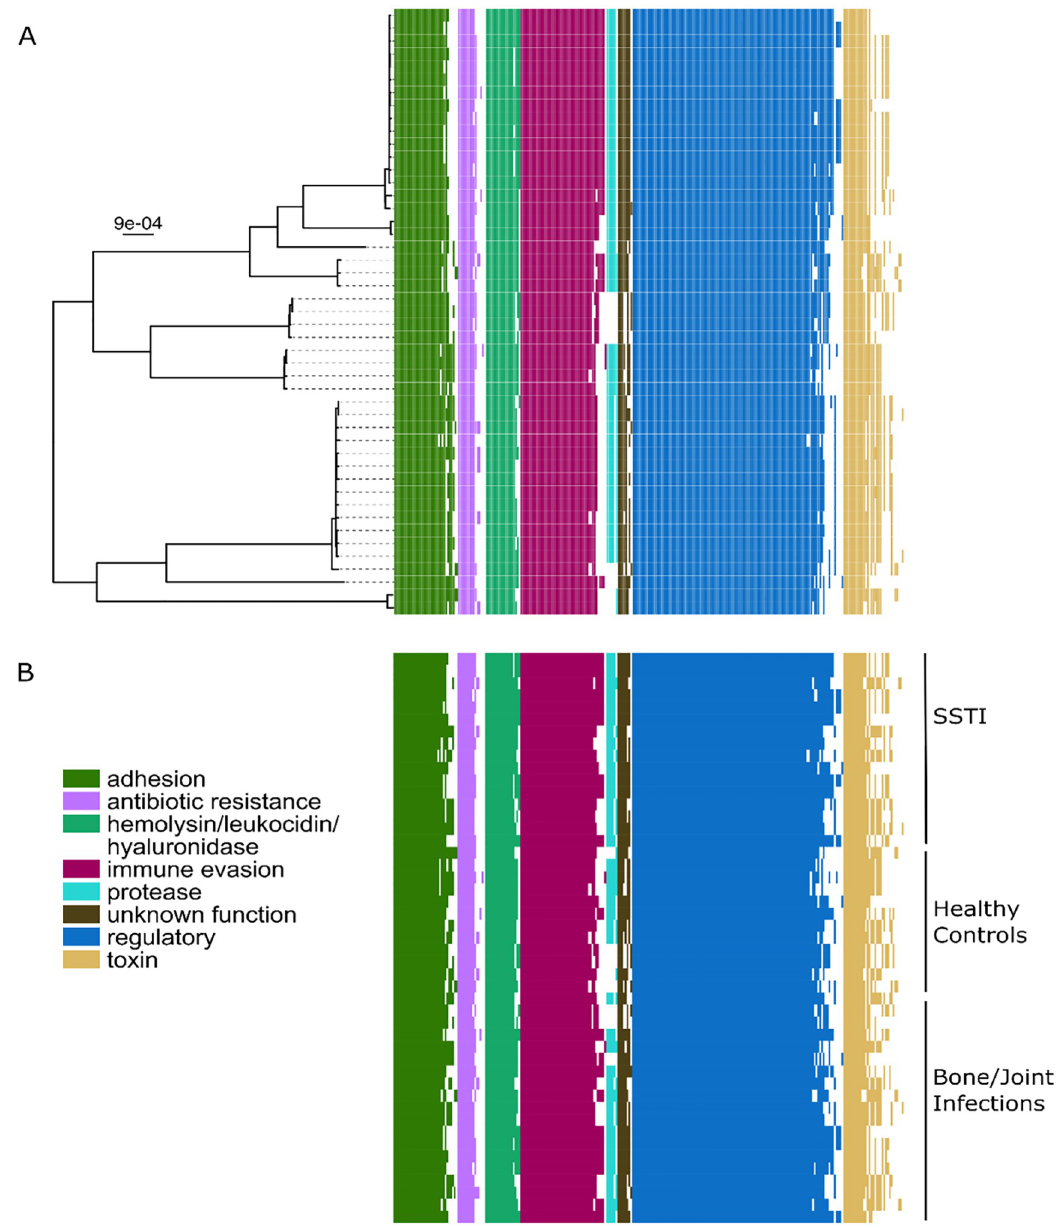
Fig 2. Presence/absence of virulence genes in Staphylococcus aureus isolates from children with osteoarticular infections compared with children with skin and soft tissue abscesses and healthy controls. A) Virulence gene presence/absence was mapped onto the core genome phylogeny for 47 Staphylococcus aureus sequences (phylogeny described in Fig 1). Colored boxes indicate presence of virulence genes. Virulence genes have been assigned to categories for analysis (adhesion, antibiotic resistance, etc.), which are listed in the legend. B) Virulence gene presence/absence is mapped by disease